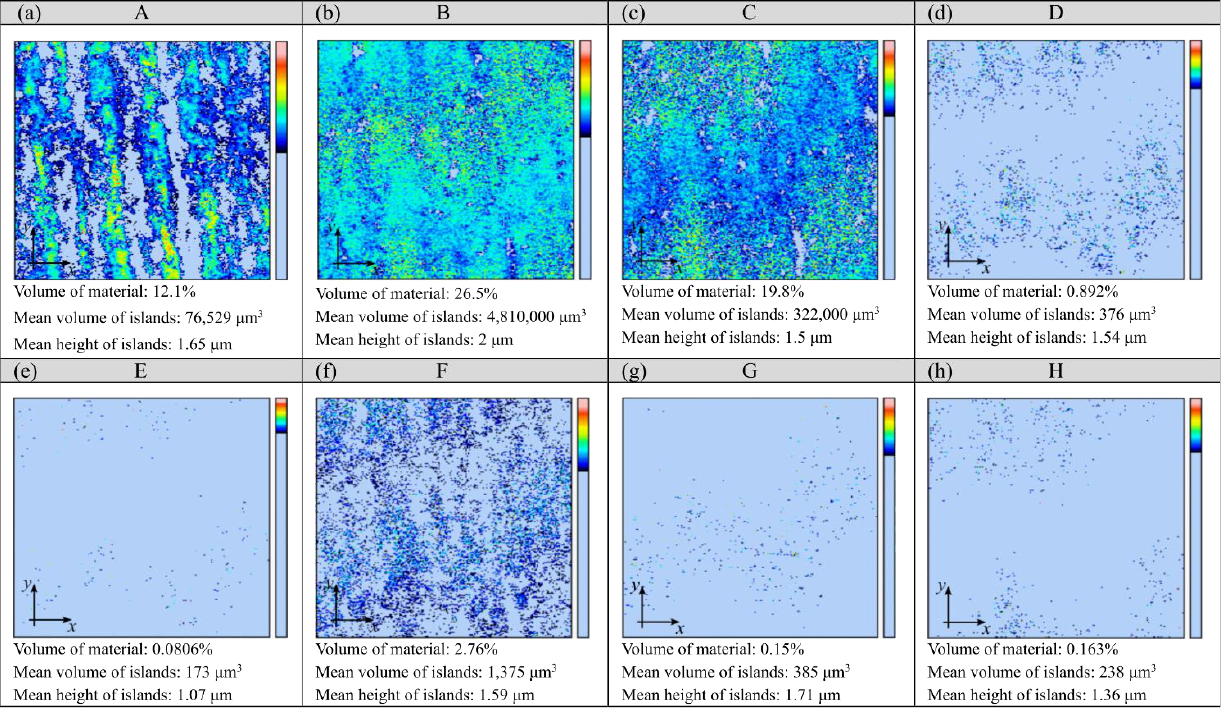
Figure 4. Results of an analysis of islands (volume and height of islands) isolated on glass workpieces (marked with uppercase letters A – H) under eight diverse smoothing process conditions ( a – h ).